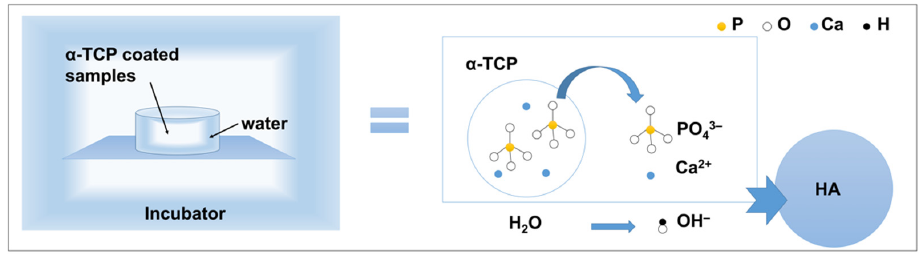
Figure 13. The schematics for hydrolysis of α -TCP to HA.